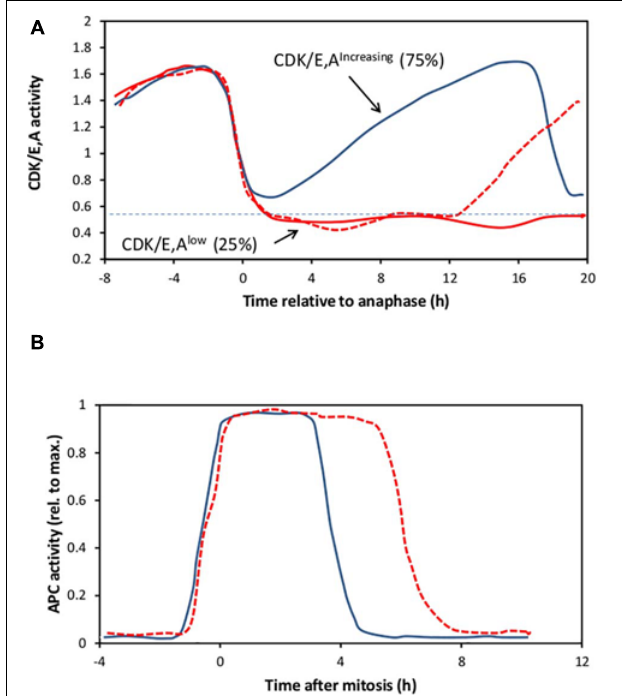
FIGURE 2 | A representation of live cell imaging data for CDK or APC activity. (A) Cartoon illustrating three single cell traces, aligned to anaphase, to indicate the range of CDK/E,A activity changes shown by individual MCF10A cells in a continuously cycling population, based on Figure 3B of Spencer et al. (2013). Following the drop in activity after mitosis, in roughly 75% of the cells (continuous blue line), activity immediately starts rising again to a peak at the next mitosis (“CDK/E,A increasing cells”). Although not indicated here, individual traces within this cohort, while following the same general pattern, nevertheless show a good deal of asynchrony. In the other 25% of the cells, activity falls to a low level (below the horizontal dotted line, at 2 h after anaphase, in this example). In these “CDK/E,A low cells,” activity either remains low until the end of the experiment (continuous red line), or spontaneously starts rising again (dotted red line) as the cell switches to the CDK/E,A increasing state. (B) Cartoon of two single-cell traces to illustrate APC activity in cycling MCF10A cells, aligned to mitosis, based on Figure 4I of Cappell et al. (2016). APC activity rises sharply as cells enter mitosis then drops precipitously to a very low level several hours later. The abruptness of the fall is similar in all cells, but its timing varies, indicating considerable asynchrony between individual